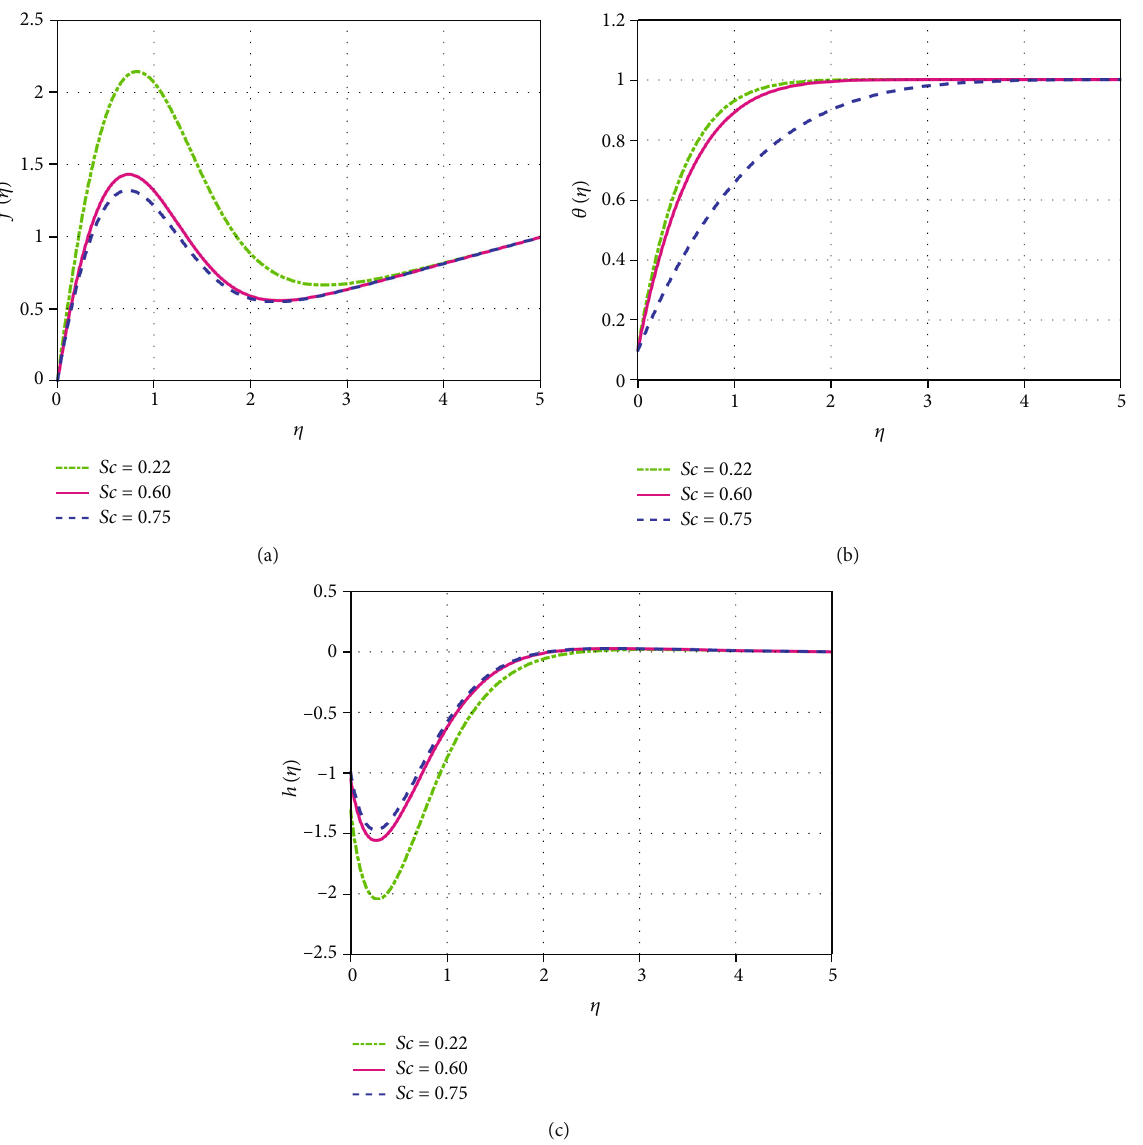
Figure 5: (a) Velocity, (b) concentration, and (c) micro-rotation pro fi les for Schmidt number variation with γ = 45 ° , M =2, c =0.5, R =0.5, Pr =0.71, L =0.33, λ = 1, ξ =3, K =0.5, Gr =10, and Gc 1 1